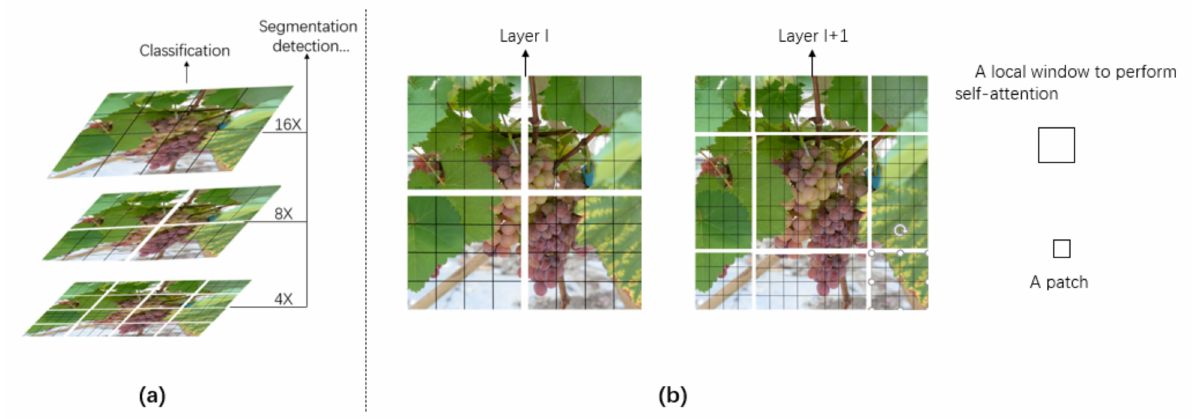
Figure 1. ( a ) The proposed Swin Transformer builds hierarchical feature maps; ( b ) an illustration of the shifted window approach for computing self-attention in the proposed Swin Transformer architecture.